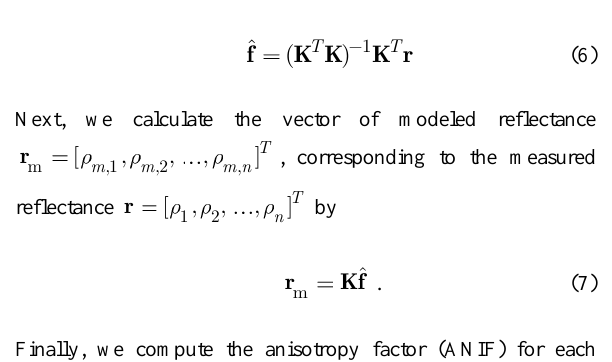
Figure 2 . The nine different materials used in experiment (a) were placed on top of a wooden plate marked with a circle of azimuths (b).